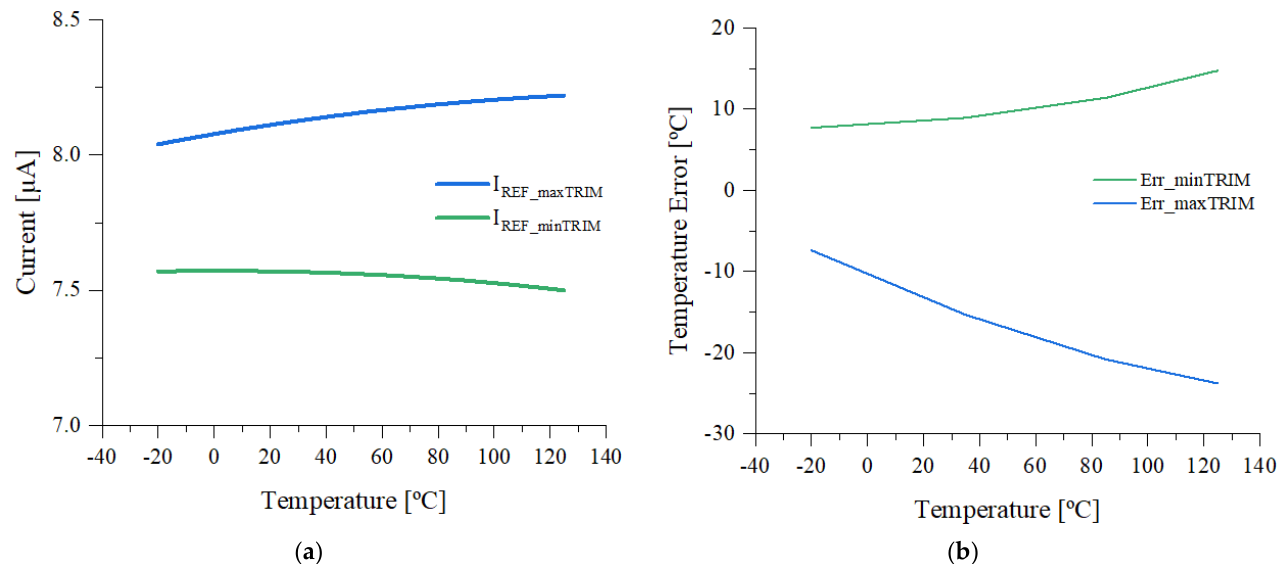
Figure 5. ( a ) Simulated dependence of the I REF with trim variation and temperature for DTS ( b ) simulated temperature error of DTS with trim variation.